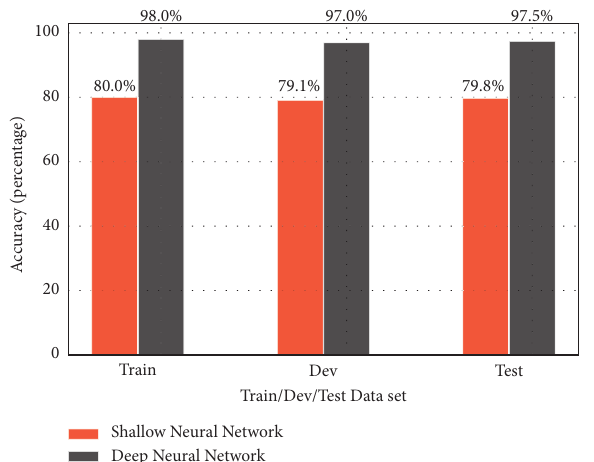
Figure 4: Performance/accuracy of learning models in the dataset.